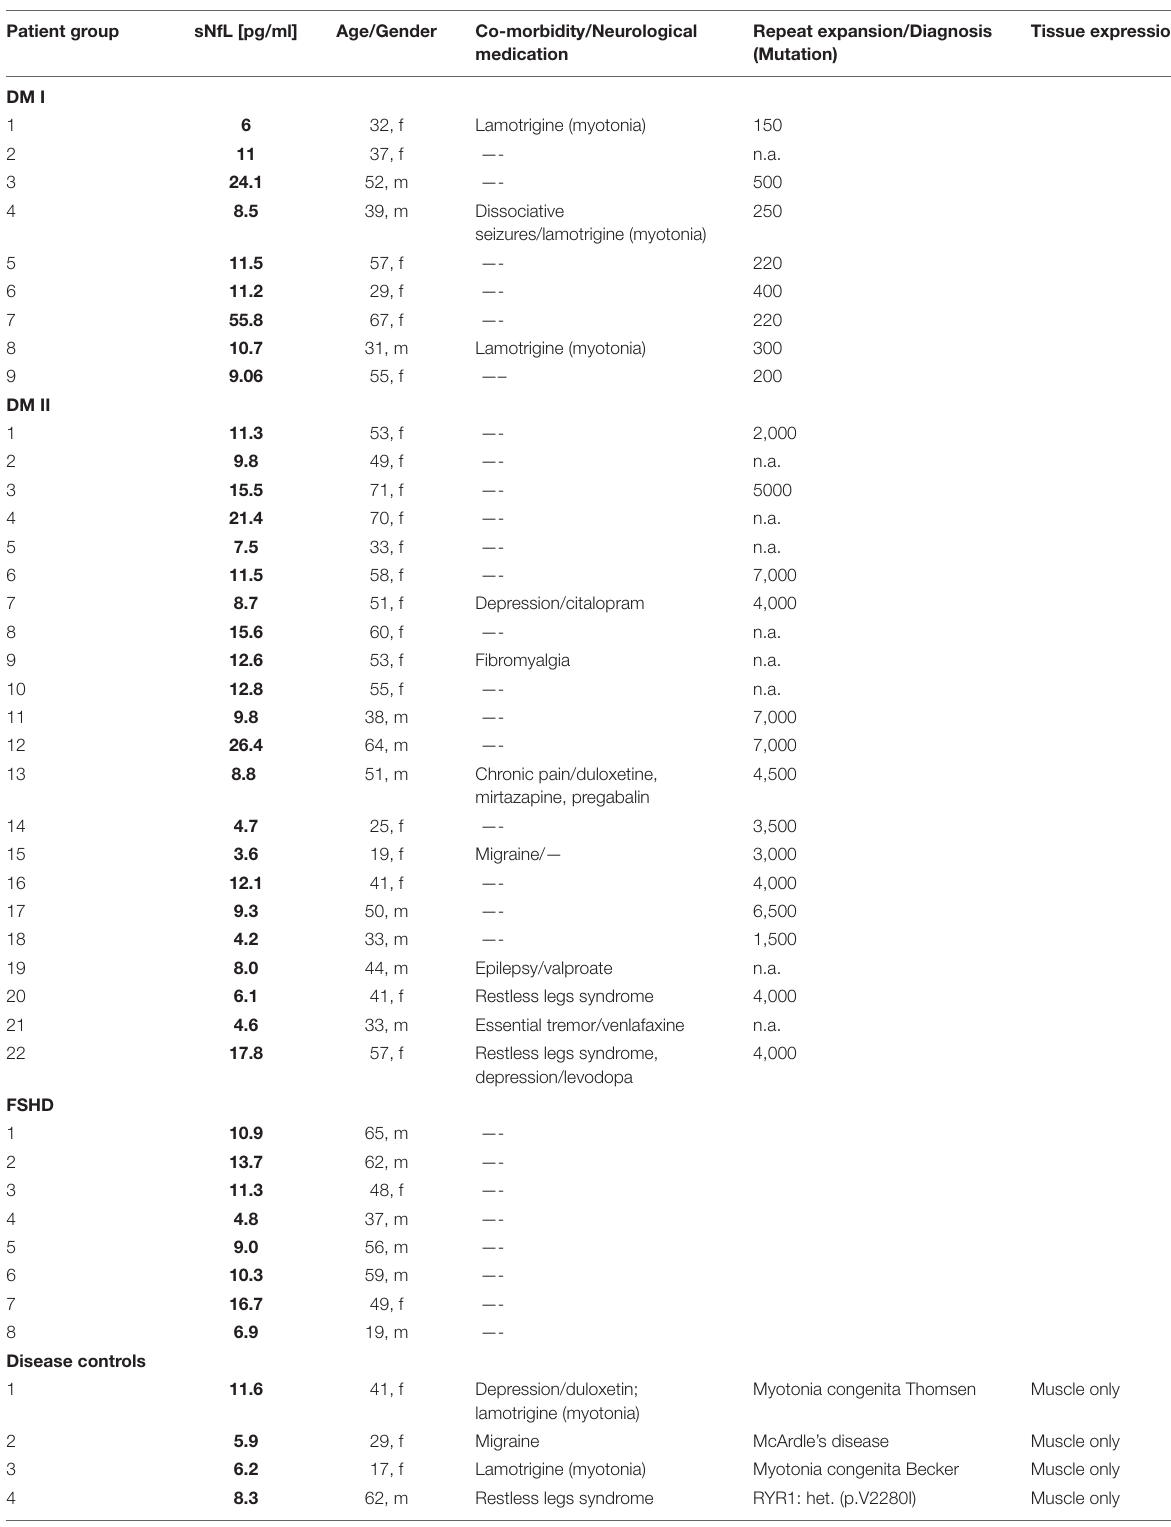
TABLE 1 | Clinical characteristics and demographics of the patient cohorts.